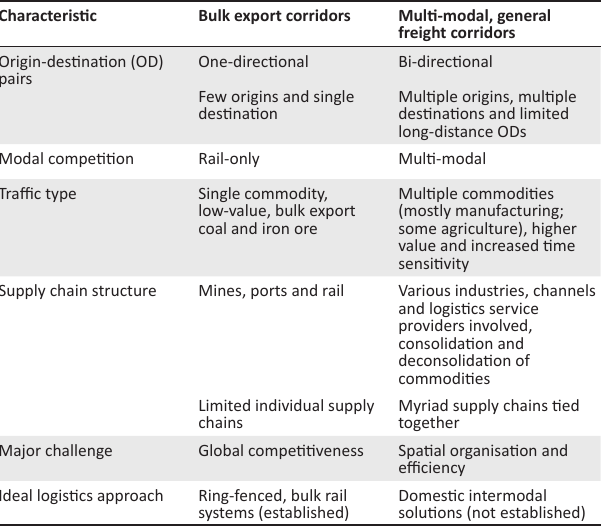
TABLE 1: Description of South Africa’s two distinct freight corridor systems. Characteristic